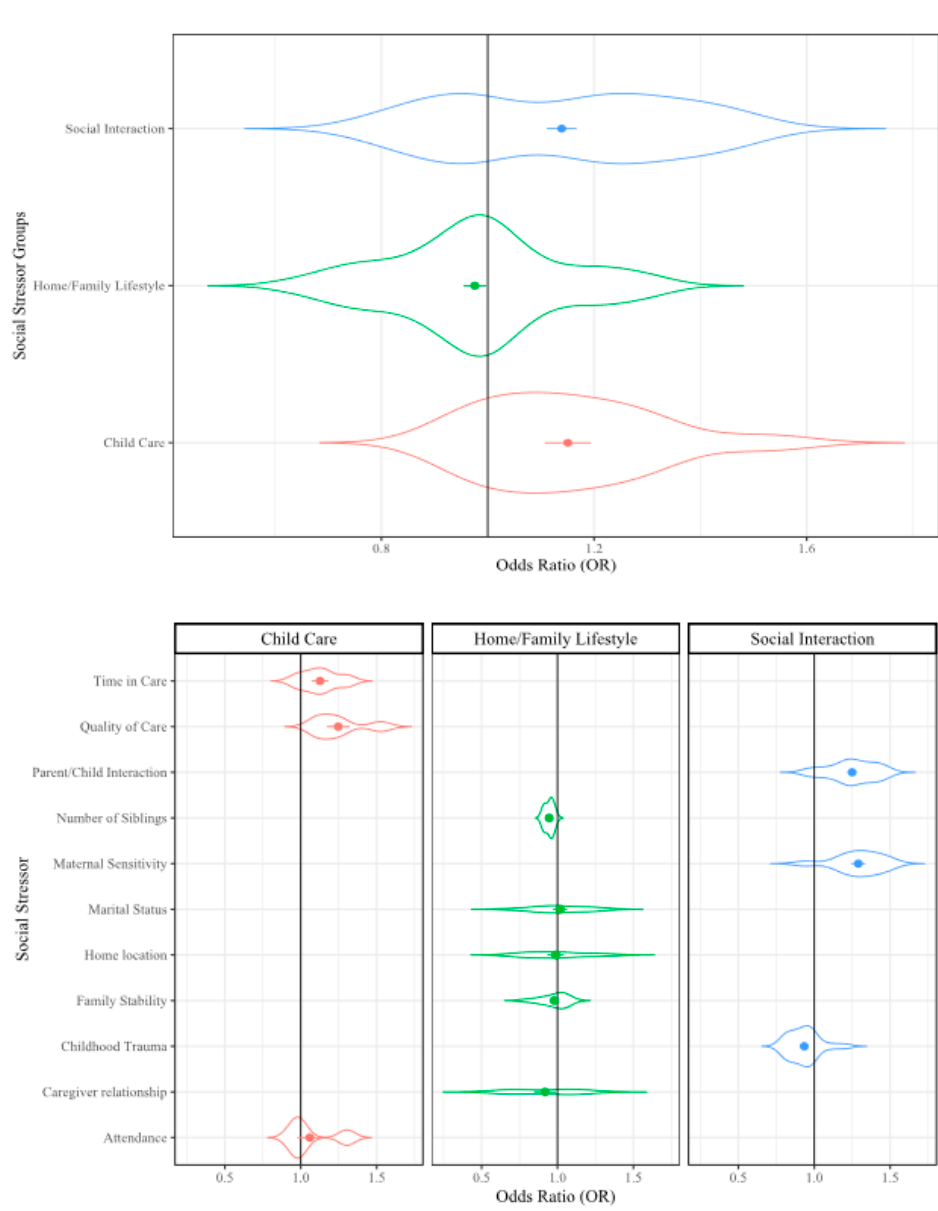
Figure 5. Violin plot of the social stressors that may influence cognitive development. Violin width represents the distribution of the Odds Ratios (OR), the height represents density of the ORs; dots represent mean OR, error bars represent mean SE.